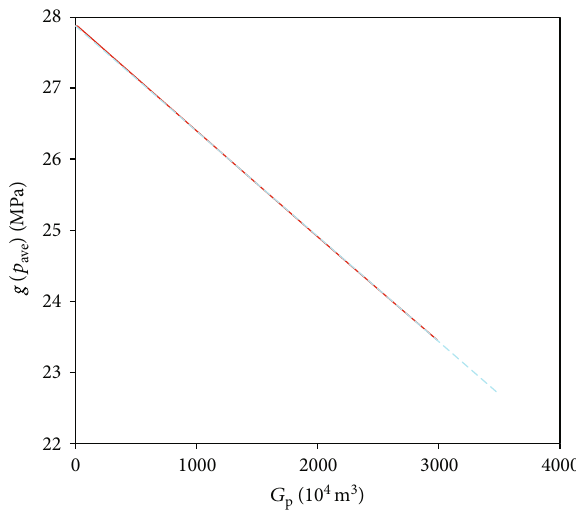
Þ to G for p ave